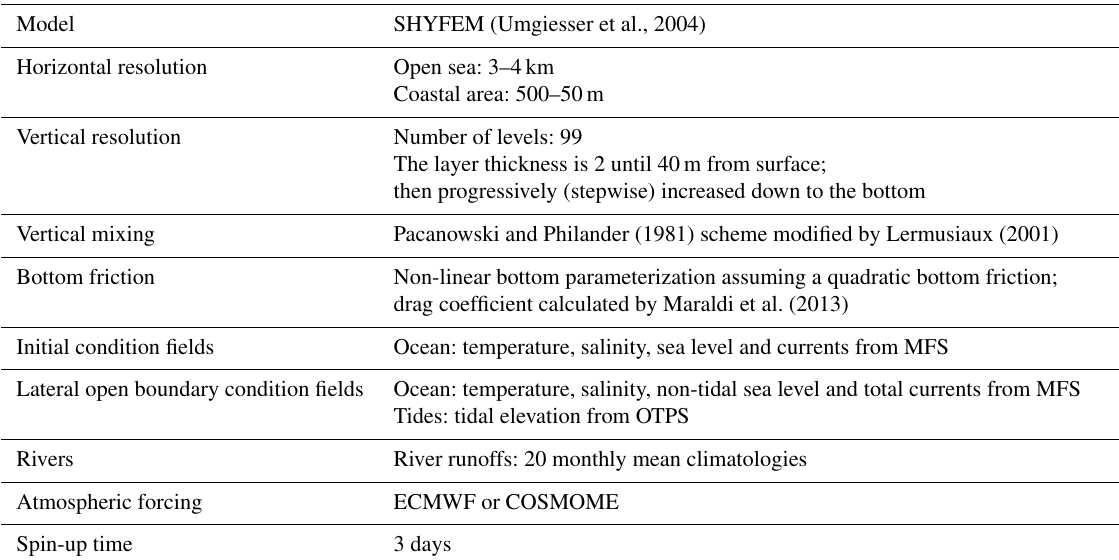
Table 1. Configuration of the SANIFS